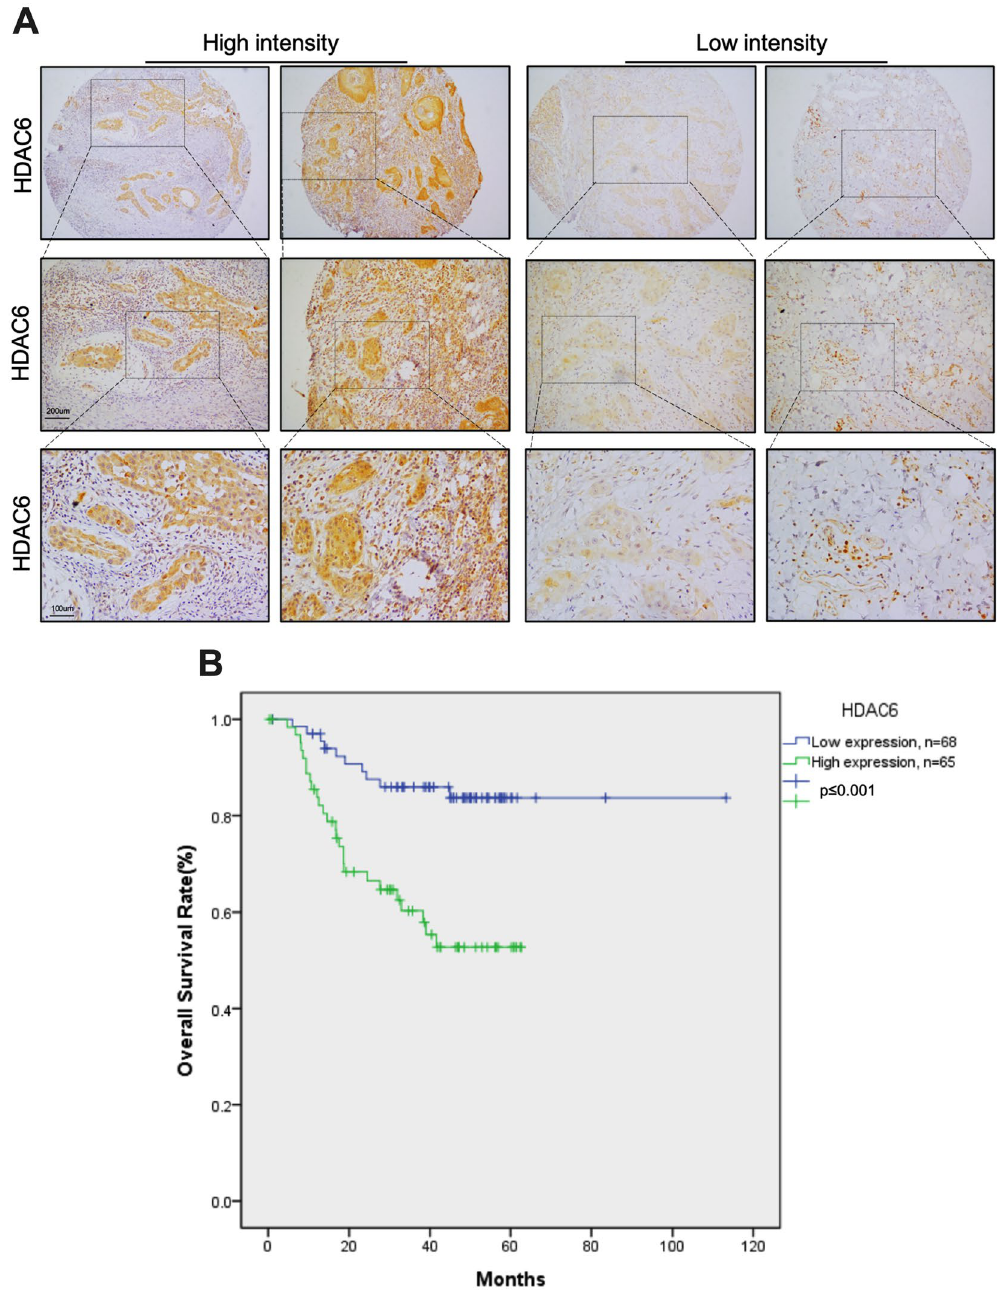
Figure 1. Overall survival rate of patients with OSCC stratified by HDAC6 expression. ( A ) Representative image of low and high HDAC6 intensity. ( B ) Curves showing the overall survival rates of patients with high (green line) versus low (blue line) HDAC6